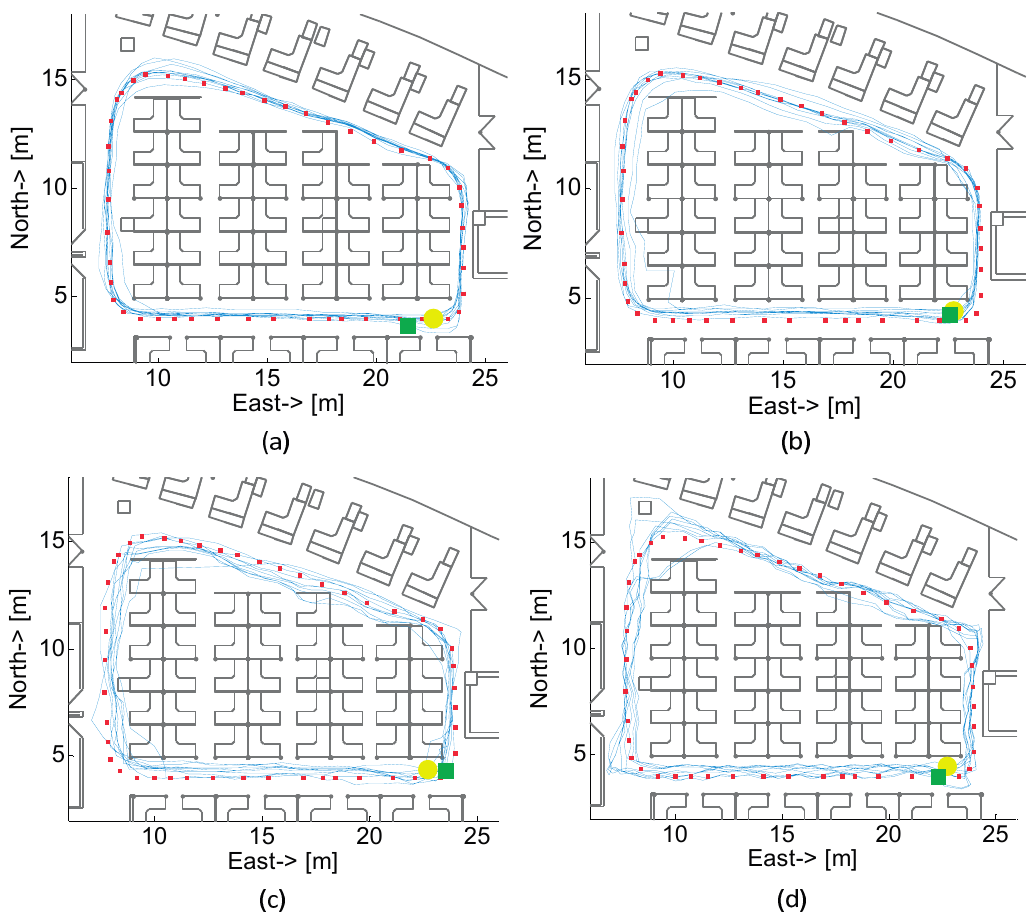
Figure 21. Estimated real-time trajectories of the pedestrian with different smartphone carrying modes: ( a ) Texting; ( b ) Calling; ( c ) In-hand; ( d )